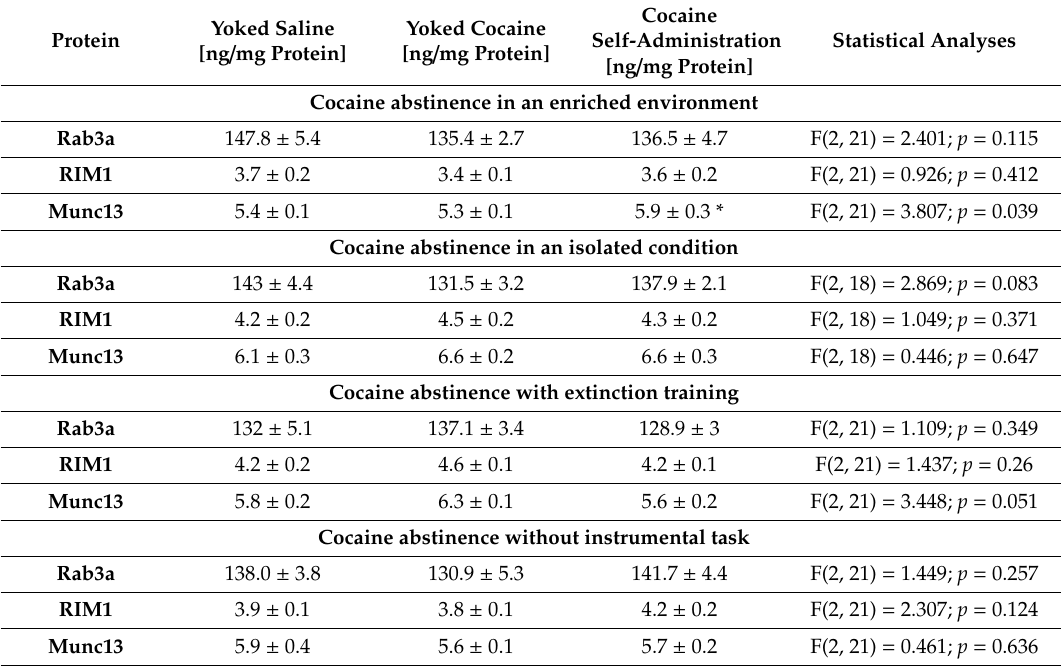
Table 3. Changes in the concentration of Rab3A. RIM1 and Munc13 in the nucleus accumbens in rats following di ff erent conditions of cocaine forced abstinence: (a) cocaine abstinence in an enriched environment; (b) cocaine abstinence in an isolated condition; (c) cocaine abstinence with extinction training; or (d) cocaine abstinence without instrumental